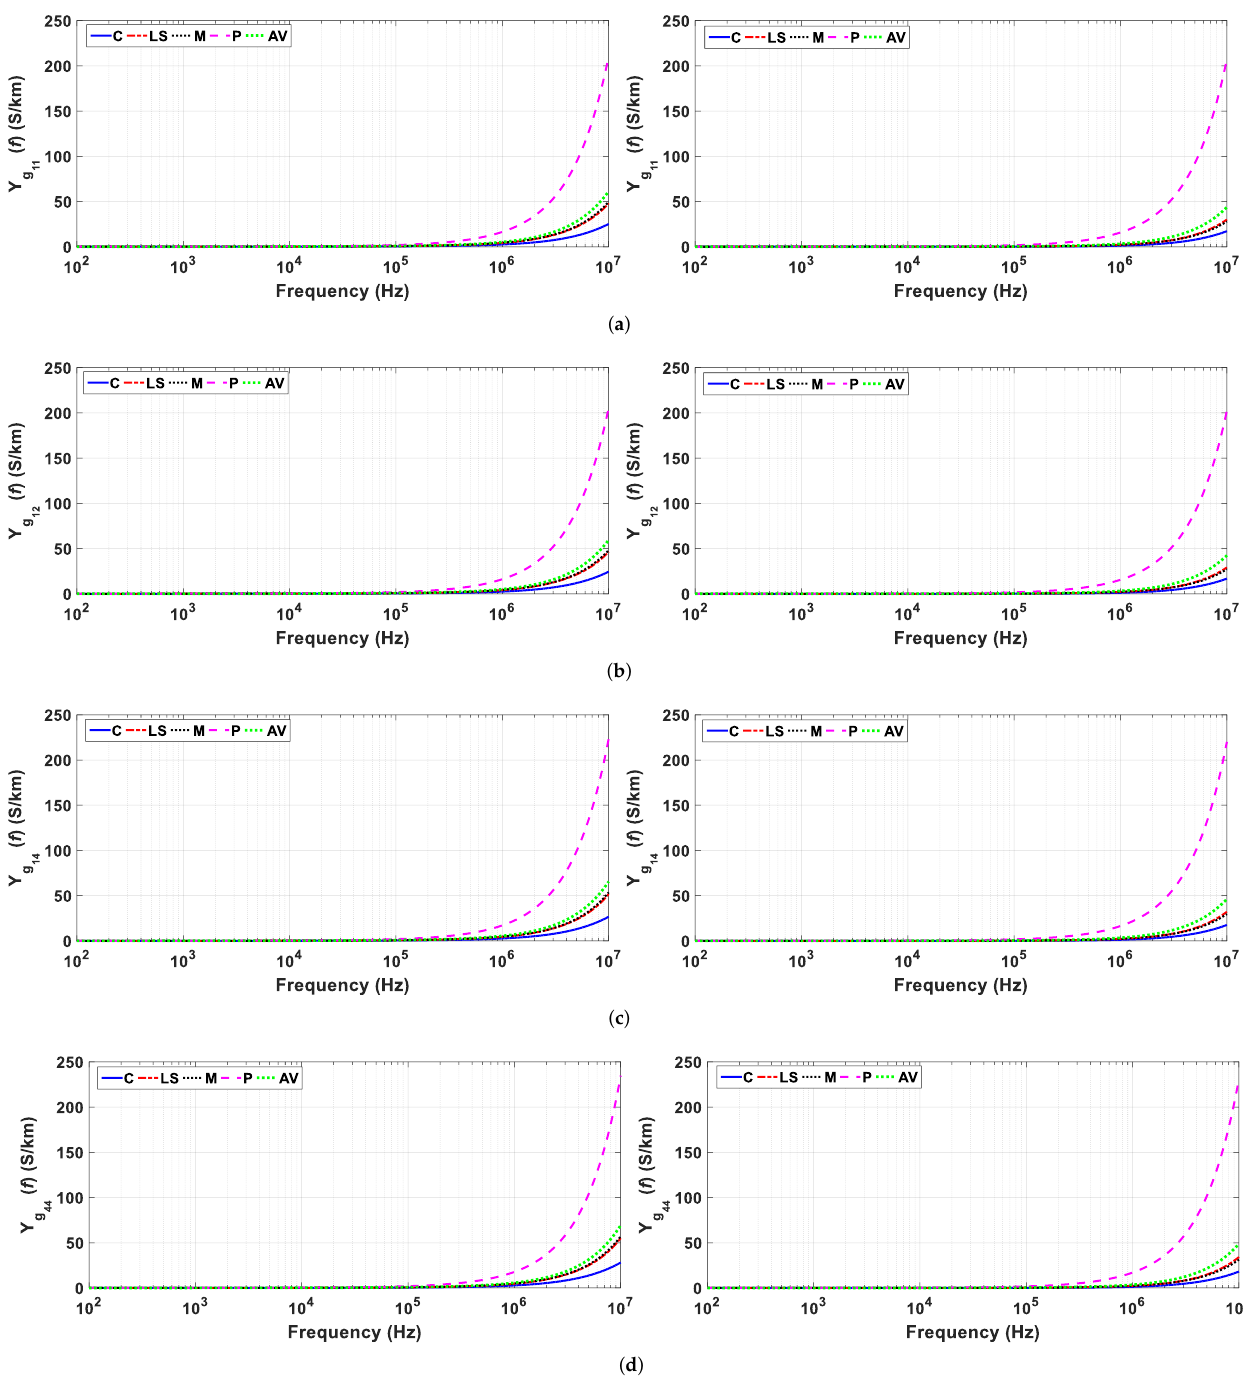
Figure 8. Magnitude of the ground-return admittance for a soil of 700 Ω · m ( left ) and 4000 Ω · m ( right ): ( a ) Y g ; ( b ) Y g ; ( c ) Y g and ( d ) Y g 11 12 14 44